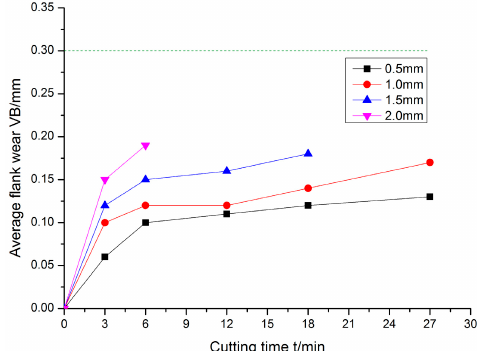
Figure 17. Evolution of VB against cutting time at different depths of cut (cutting speed of 50 m/min, feed rate of 0.1 mm/r).